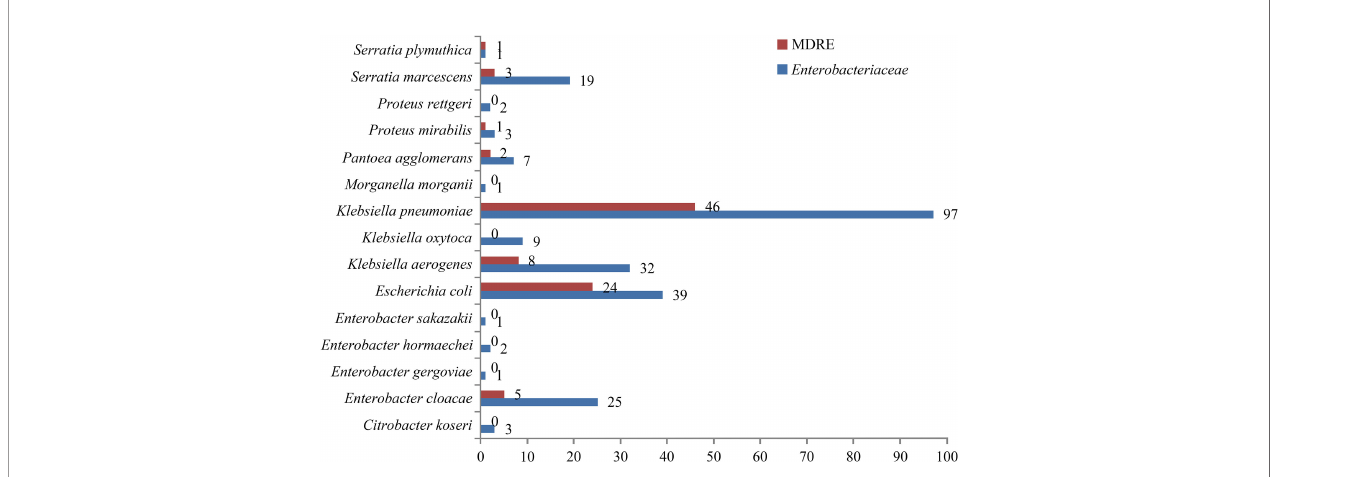
FIGURE 3 | Number and distribution of NM caused by Enterobacteriaceae and MDRE. MDRE , multidrug-resistant Enterobacteriaceae; NM ,